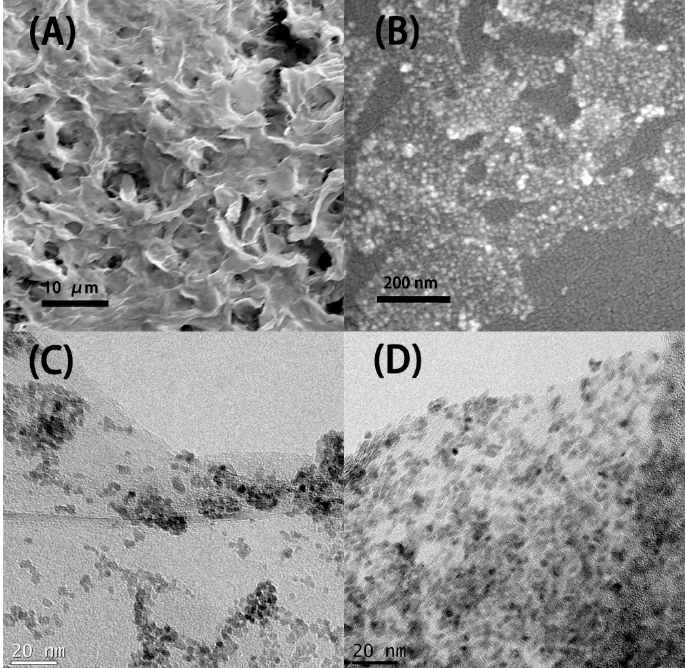
Figure 2. SEM ( A,B ) are images of the SnO 2 -decorated rGO synthesized by the modified two-step process. TEM ( C ) is the image of the SnO 2 -decorated rGO synthesized by the traditional one-step process. ( D ) is the image of the SnO 2 -decorated rGO synthesized by the modified two-step process. The modification in the two-step process resulted in a more uniform distribution and higher loading rate of the SnO 2 nanoparticles. Samples were prepared from dispersions of the material in n-methyl pyrrolidone (NMP).